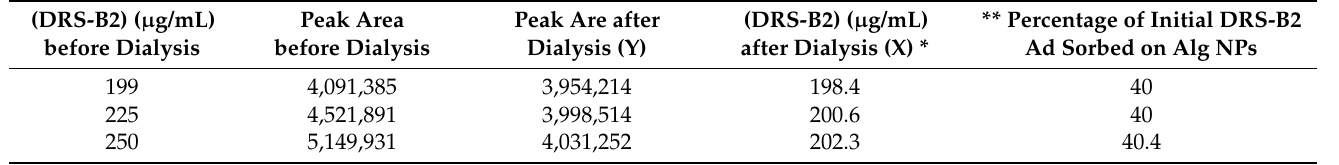
Table 2. Concentrations of DRS-B2 adsorbed on Alg NPs (500 µ g/mL) after